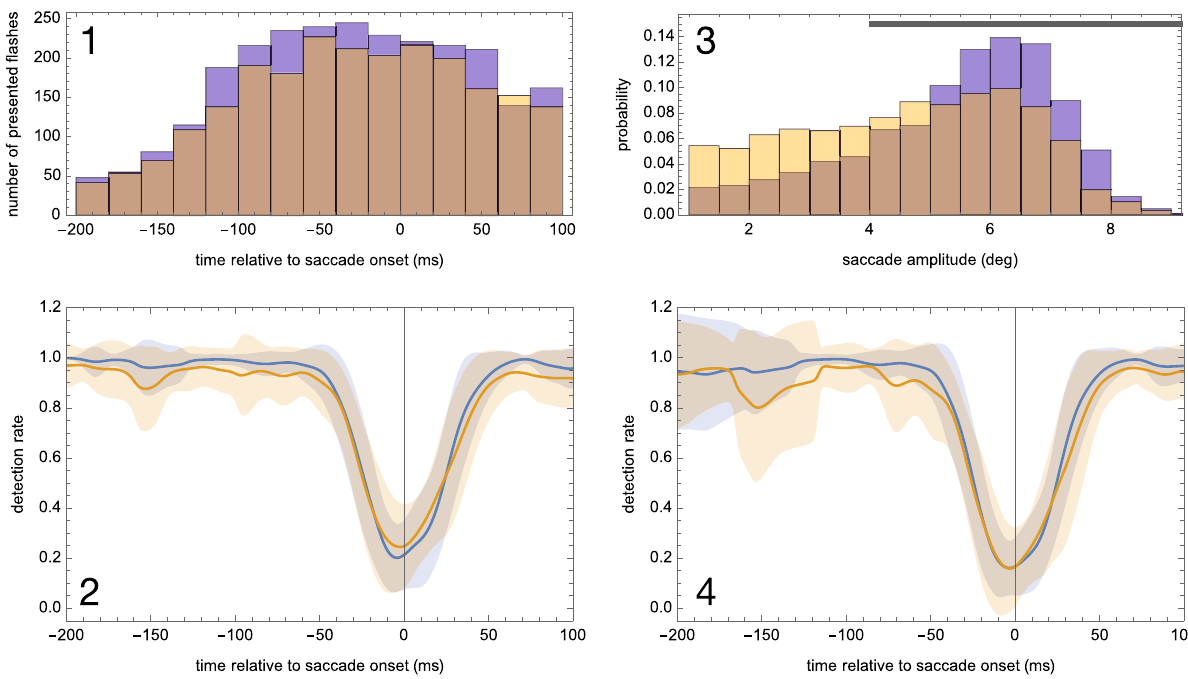
Figure 2. ( 2-1 ) Distribution of Gabor flashes relative to saccade onset in patients with schizophrenia (yellow) and healthy controls (blue). Overlap between groups is indicated in brown. Note, distribution of Gabor flashes was similar in both groups. ( 2-2 ) Mean probe detection rates with standard deviations related to saccade onset in patients with schizophrenia (N = 17) and healthy controls (N = 18). Detection rates are depicted as running averages. Detection rate around saccade onset did not differ between patients and controls, nor was there any evidence for prolonged backwards masking starting earlier in patients. However, baseline detection rate in the interval 200 ms to 70 ms before saccade onset was slightly, but significantly, lower in patients than controls. ( 2-3 ) Distribution of saccade amplitudes in patients with schizophrenia (yellow) and healthy controls (blue) during the saccadic suppression task. Overlap between groups is indicated in brown. Black bar indicates range of amplitudes used in the analysis below ( 2-4 ). ( 2-4 ) Similar to ( 2-2 ) but based on only amplitudes > 4°. Note, the suppression at saccade onset is even more similar between the groups than in ( 2-2